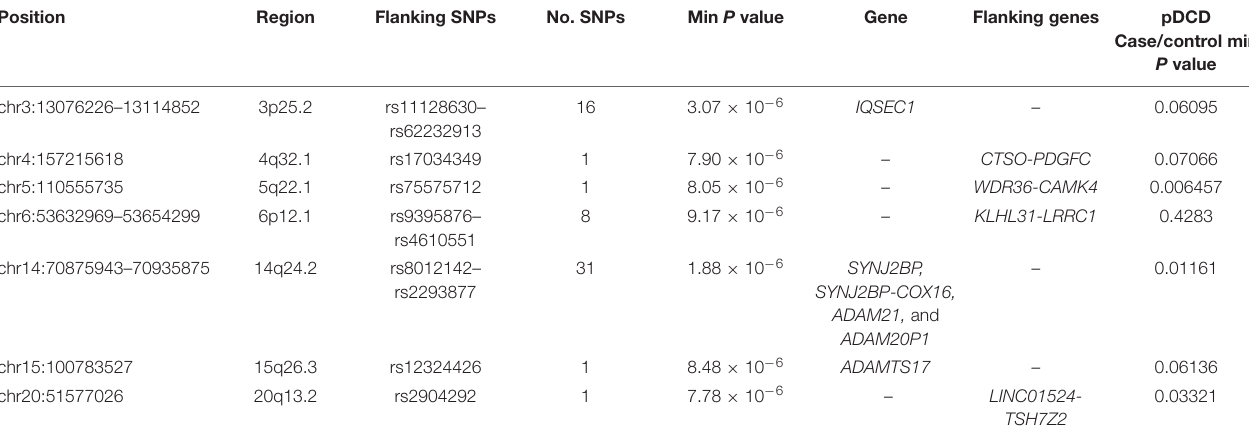
TABLE 1 | Motor coordination (SumQMS4) GWAS top-hits by regions. Position Region Flanking SNPs No. SNPs Min P value Gene Flanking